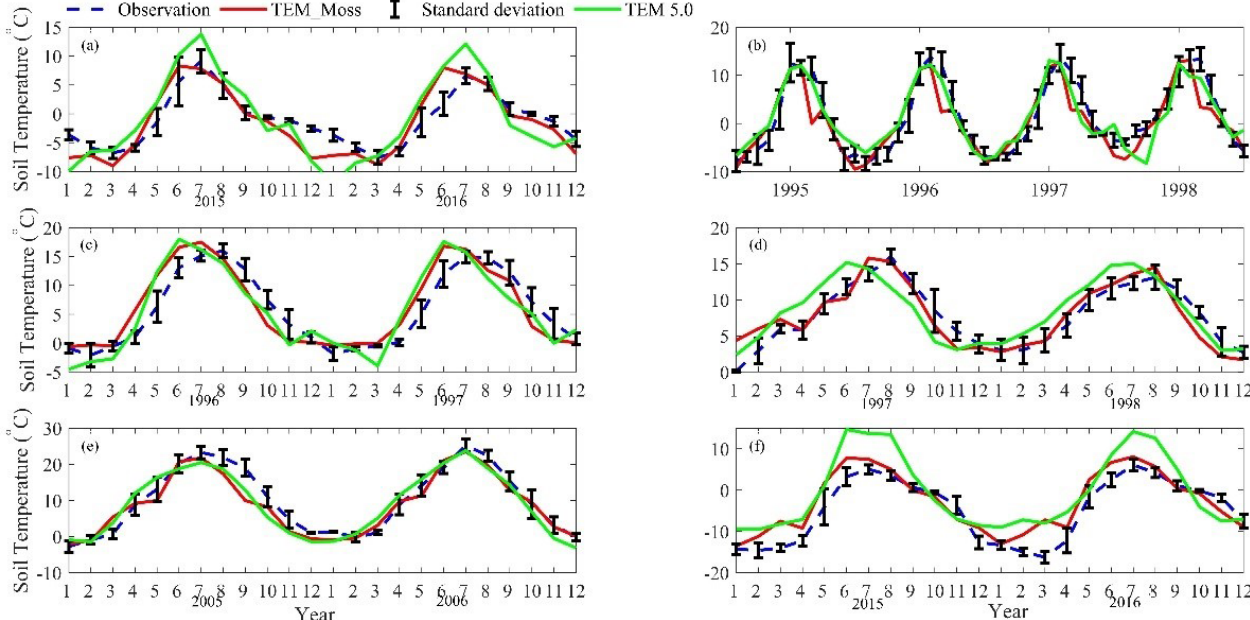
Figure 8. Comparison between observed and simulated soil temperature at 5cm depth ( ◦ ) at (a) US-Ivo (alpine tundra), (b) BOREAS NSA- OBS (boreal forest), (c) US-Ho1 (temperate coniferous forest), (d) BE-Vie (temperate deciduous forest), (e) US-Bkg (grassland), and (f) US-Atq (wet tundra). Table 8. Model validation statistics for TEM_Moss and TEM 5.0 at six sites with soil temperature at 5cm depth